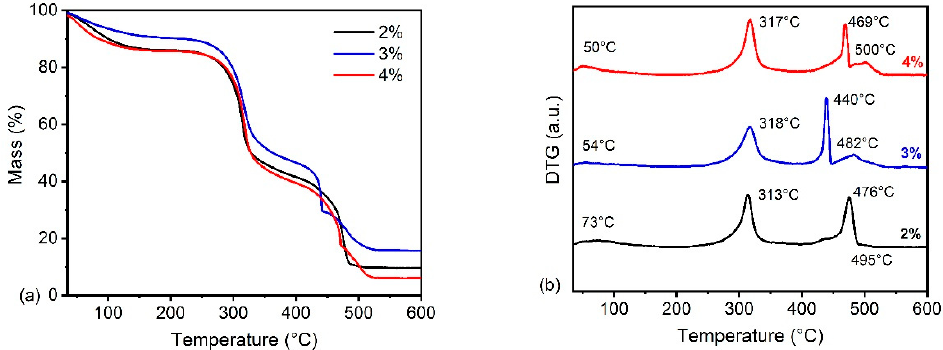
Figure 4. Thermogravimetric curves of hemicellulose films.